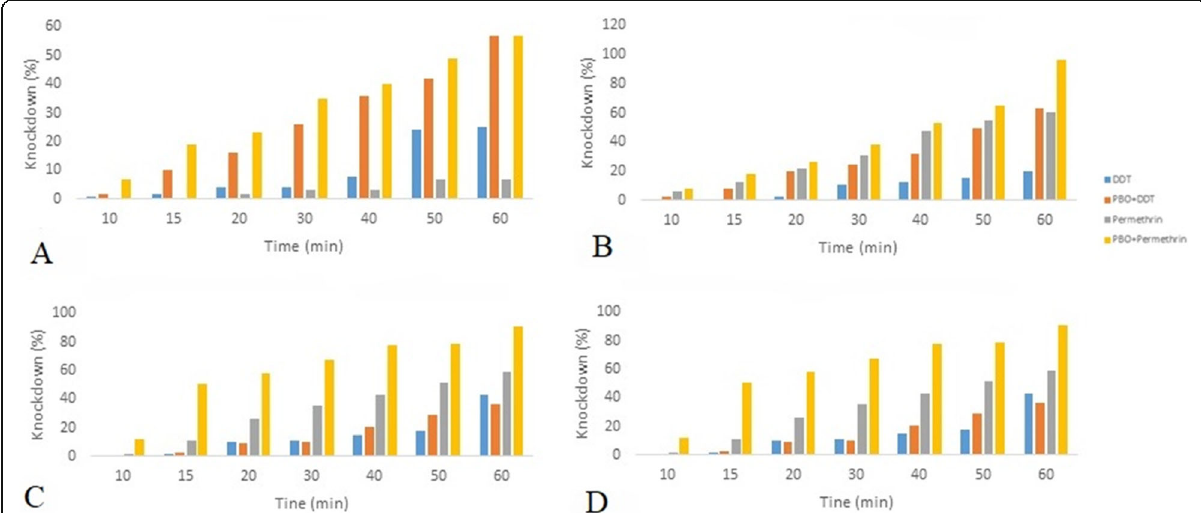
Fig. 1 a – d Percentage knockdown time comparison of Aedes aegypti between PBO synergized and non-synergized assay in Kosofe, Ibeju-Lekki, Alimosho, Badagry LGAs